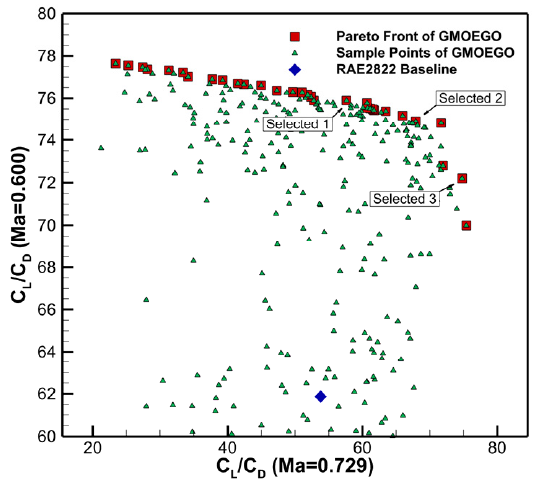
Figure 10. Optimization results of the GMOEGO algorithm.